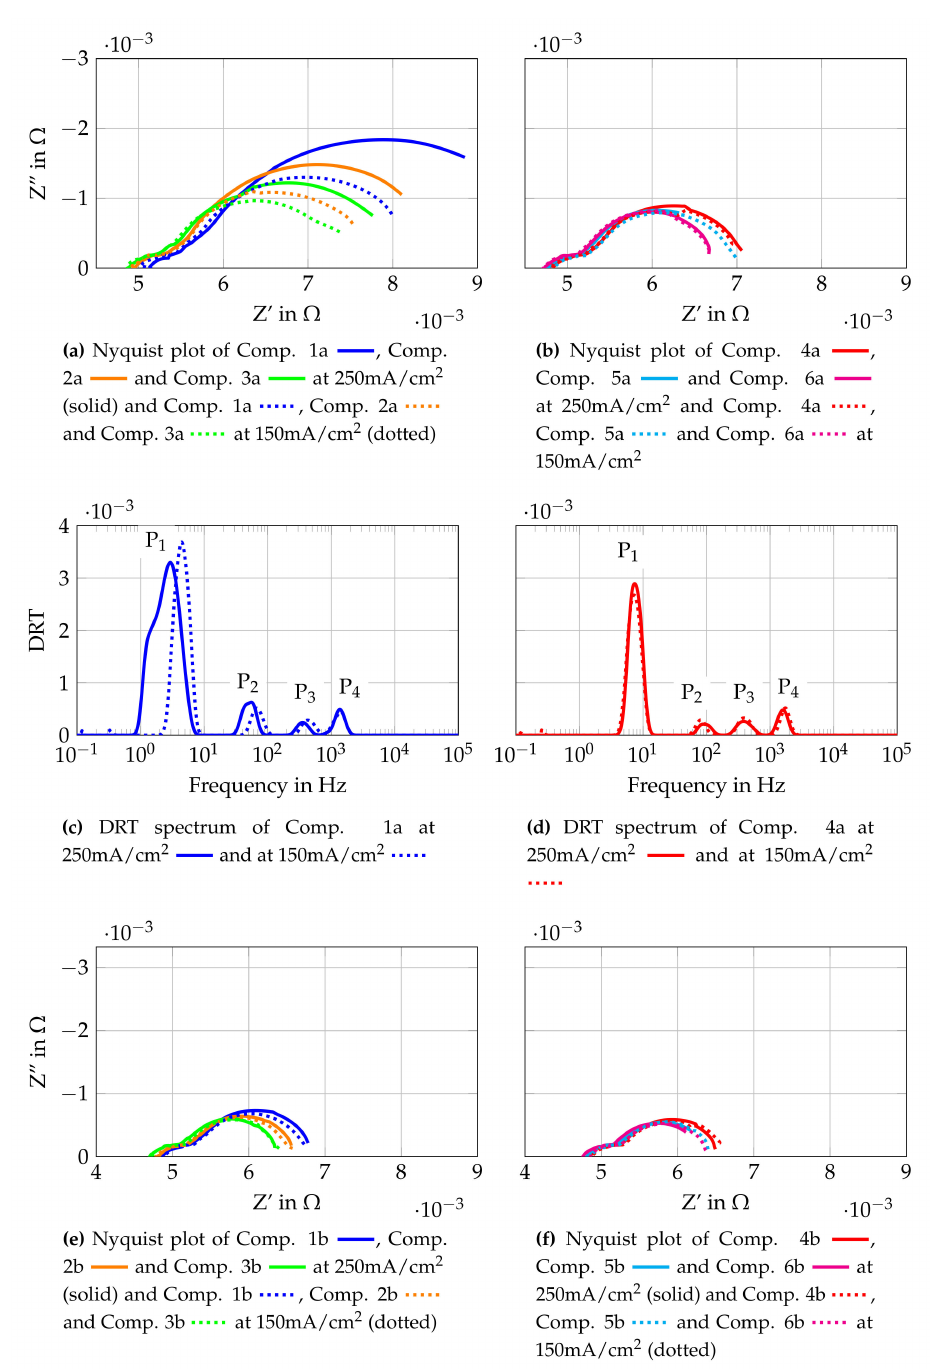
Figure 11. Cell characterization with gas mixtures obtained from auto-thermal reformed